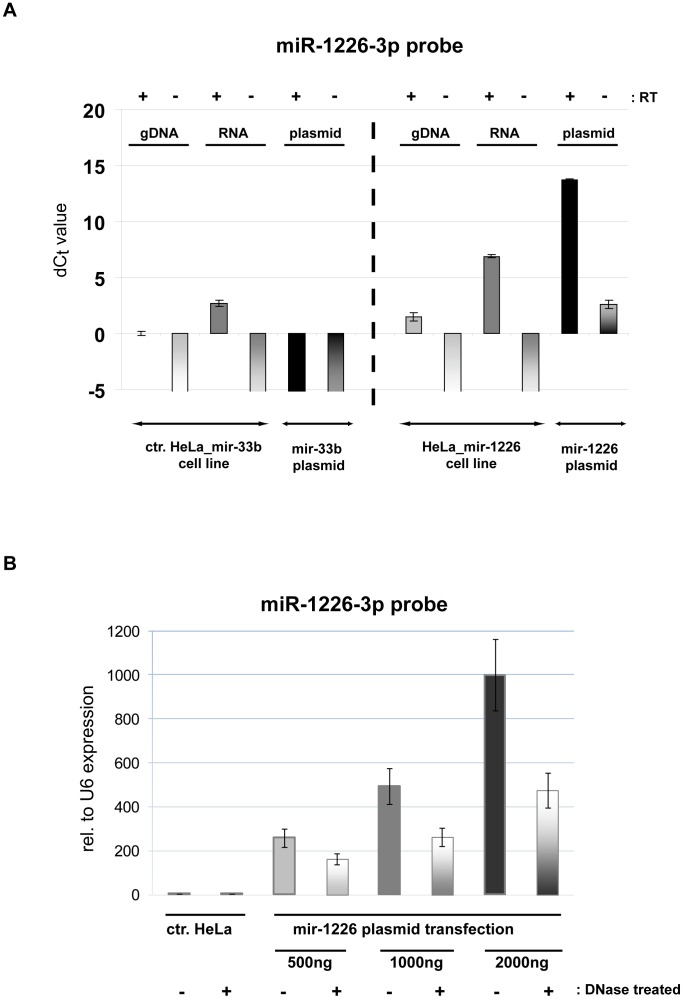
DNA can serve as a template during miRNA detection.(A) False positive signal of DNA derives mainly from the reverse transcription reaction. Mature miR-1226-3p was tested in the indicated samples, with or without reverse transcription (RT). On the y-axis, dCt value is represented, calculated as the Ct difference between the examined samples and the gDNA of control HeLa_mir-33b cell line (Ct = 35,9). One Ct difference represents about 2× higher detected mature miRNA level. (B) DNA contamination remains in total RNA samples during isolation by the widely used Trizol reagent. Total RNA samples were isolated from transiently transfected HeLa cells; the transfected plasmid DNA amounts are indicated. Samples were DNase treated and non-treated, then reverse transcribed and subjected to real-time PCR. Expression values relative to U6 snRNA are shown on the y-axis. Experiments were carried out with three replicates at least from three independent experiments; one representative experiment is shown, error bars represent standard deviations.